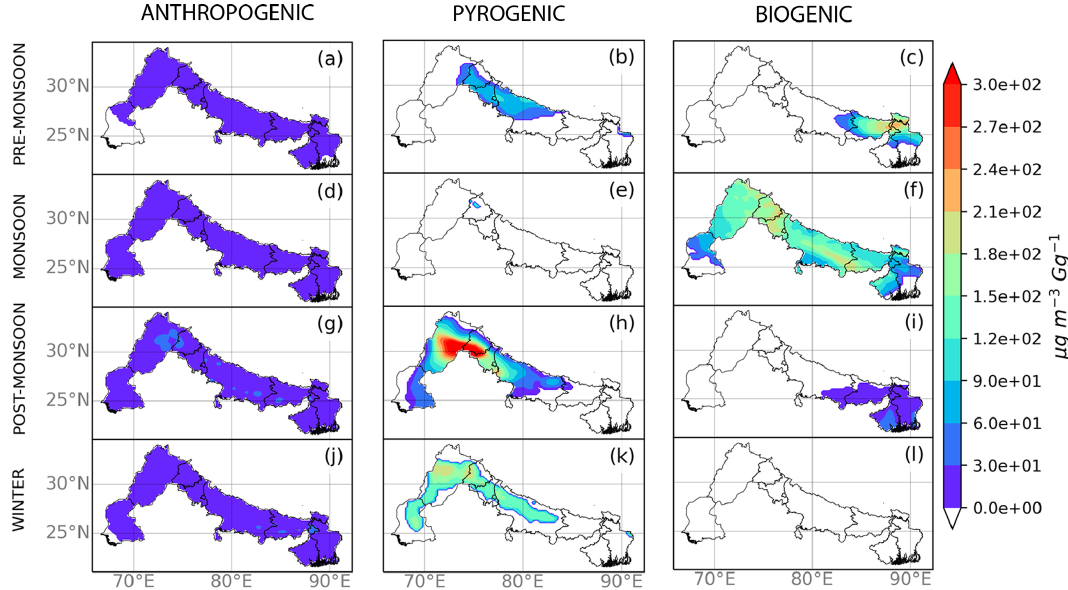
Figure A5. As Fig. A4 but for SOA.